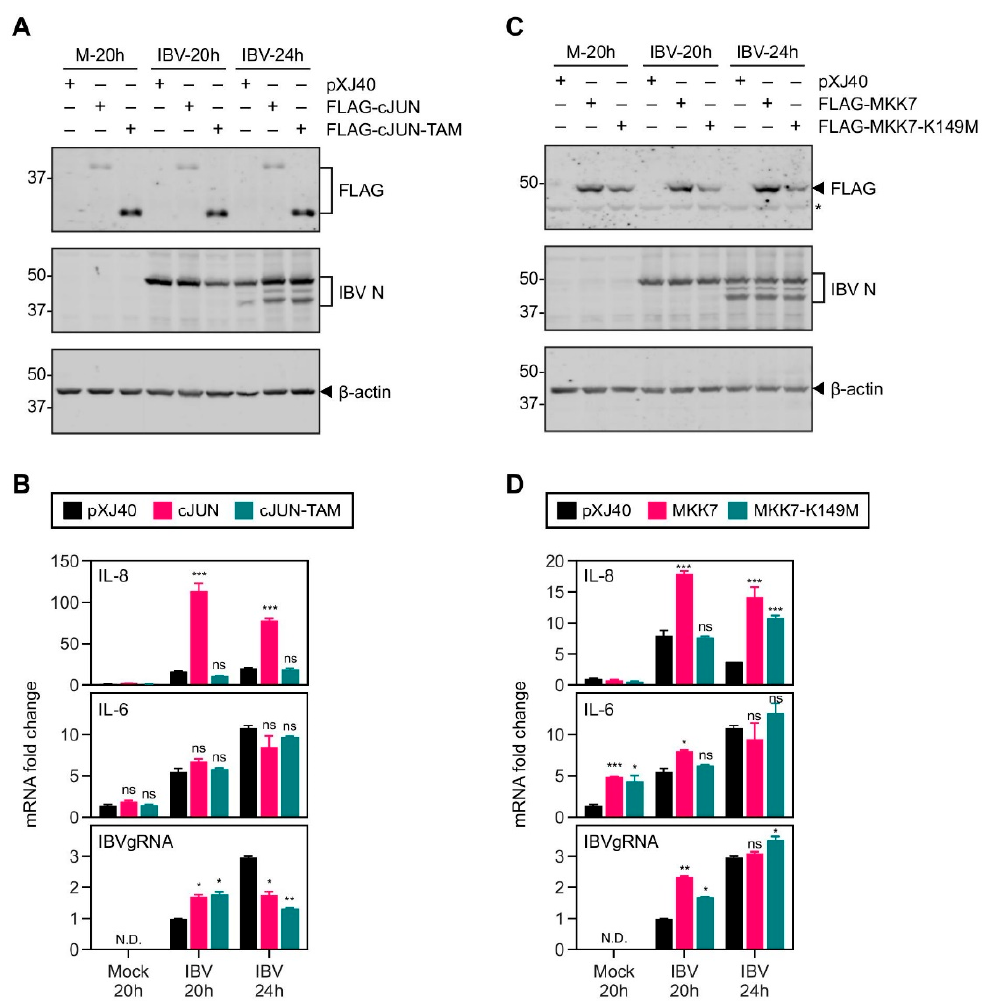
Figure 6. Activation of the MKK7-JNK-cJUN pathway promoted the induction of IL-8 mRNA in cells infected with IBV. ( A ) H1299 cells were transfected with pXJ40 , pXJ40-FLAG-cJUN , or pXJ40-FLAG-cJUN-TAM , before being infected with IBV at MOI~2 or mock infected (M). Cell were harvested at the indicated time points and subjected to Western blot